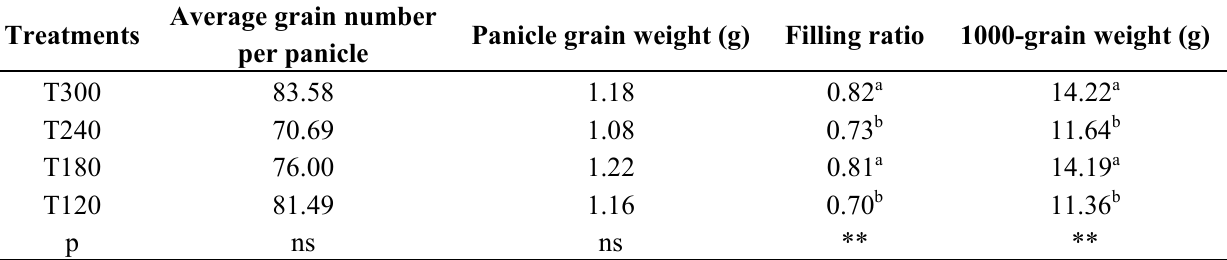
Table 3. Effects of water reduction on grain production.